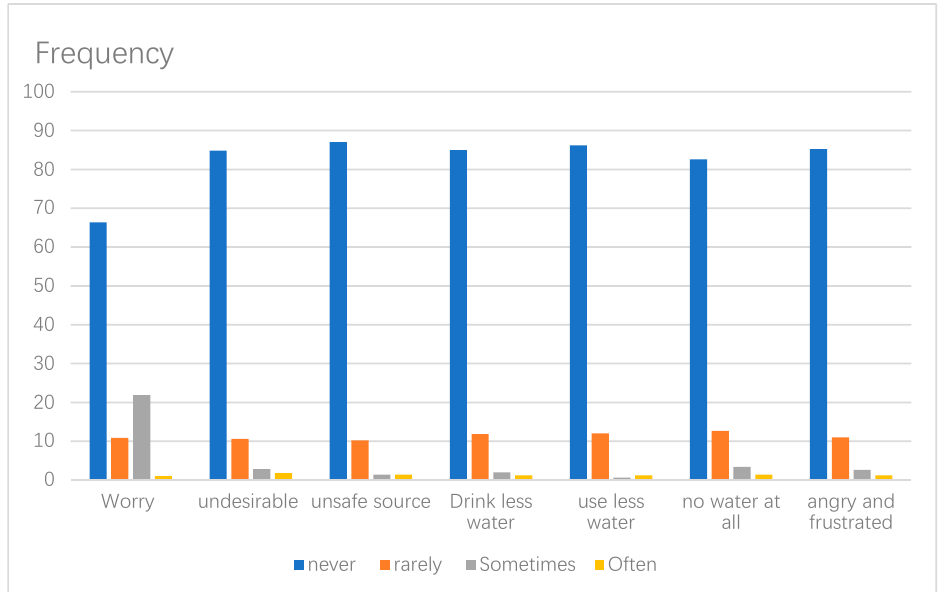
Figure 2. Experiences with water insecurity in the past 30 days in slums in Greater Accra.